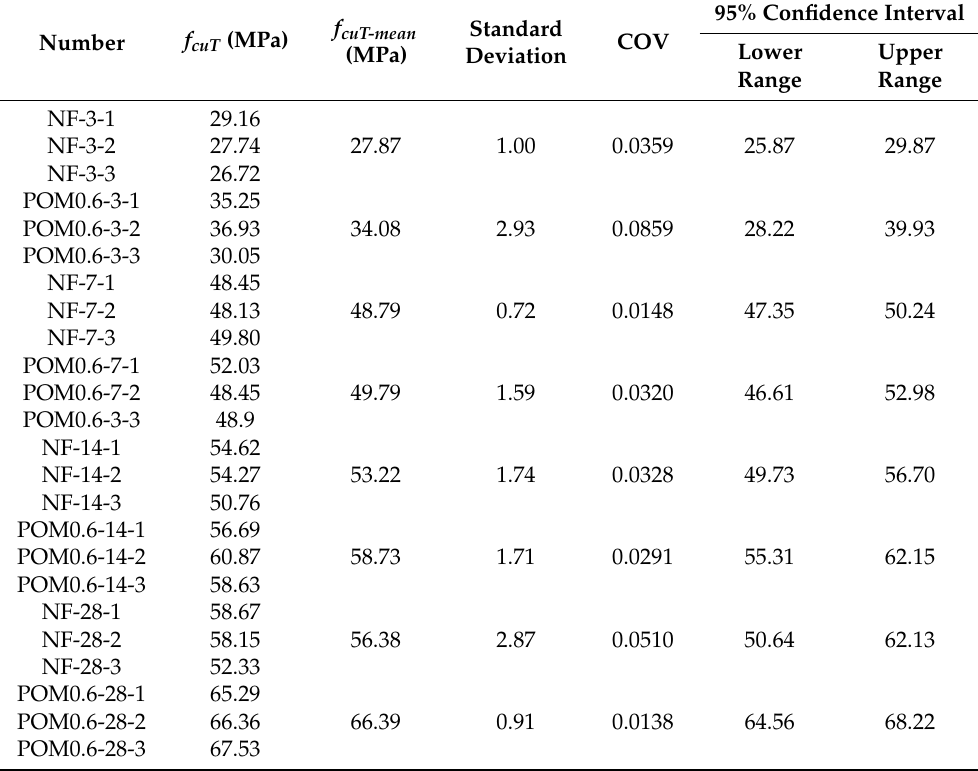
Table 5. Cube compressive strength of NF and POM0.6 SWSSC specimens with different